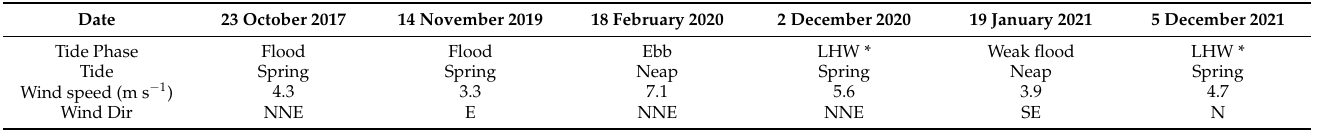
Table 4. Tidal phase and wind conditions at the satellite image acquisition times.